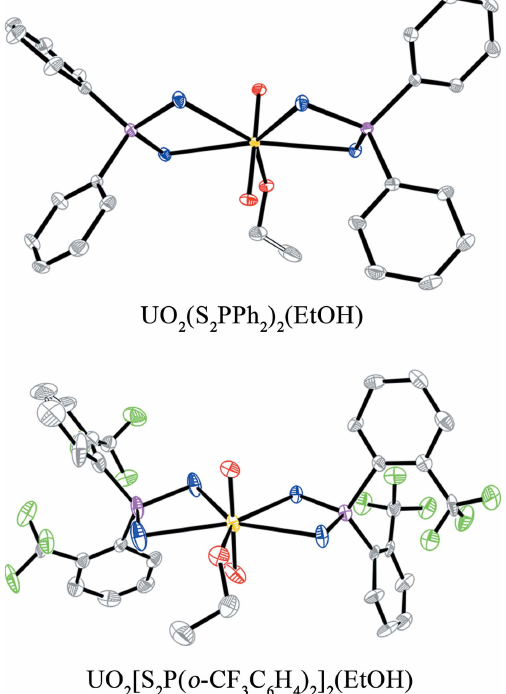
Figure 1 Crystal structure of UO 2 (S 2 P R 2 ) 2 (EtOH) investigated in this work with thermal ellipsoids drawn at the 30% probability level. H atoms have been omitted for clarity. (U: yellow; S: blue; P: pink; O: red; C: white; F: